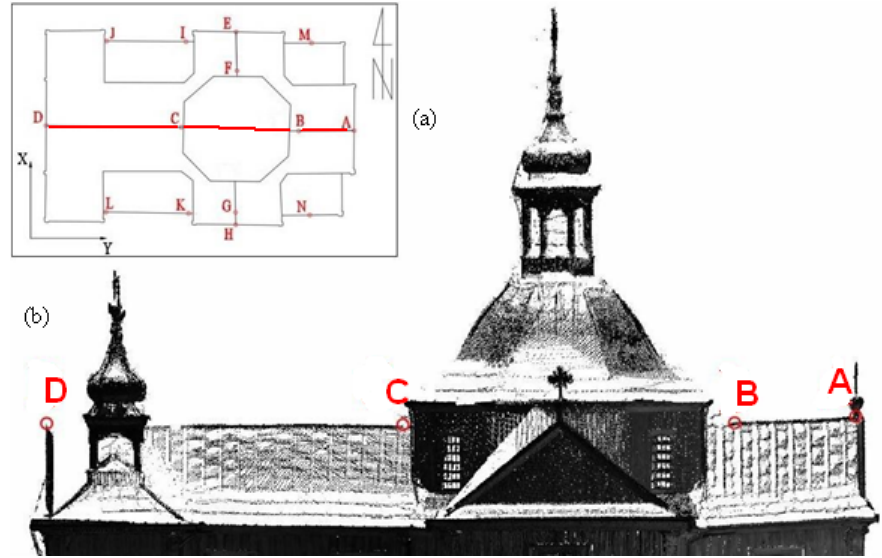
Figure 12. View of the ridge of the church roof, west-east (( a )—view from the top and ( b )—side